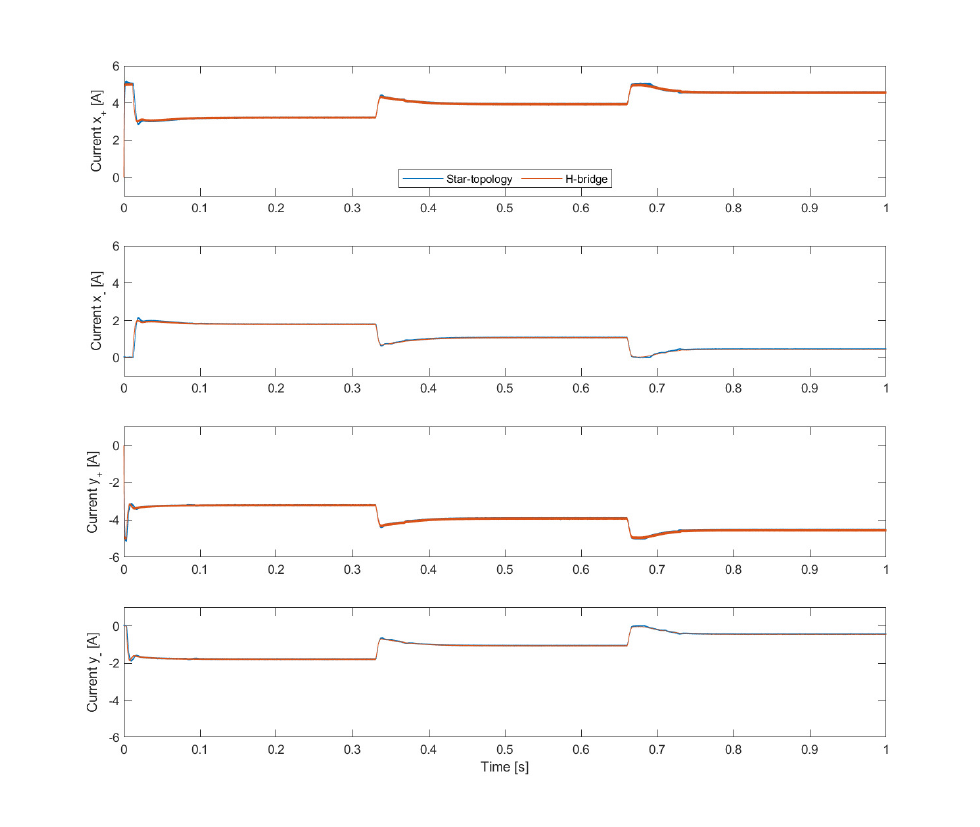
Figure 14. Comparison of phase currents of both